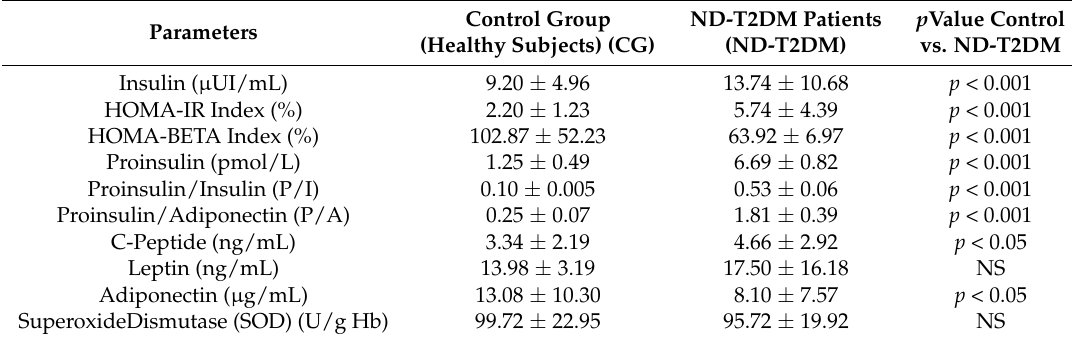
Table 3. The values of parameters relevant to the assessment of pancreatic cell function, adipose tissue and oxidative